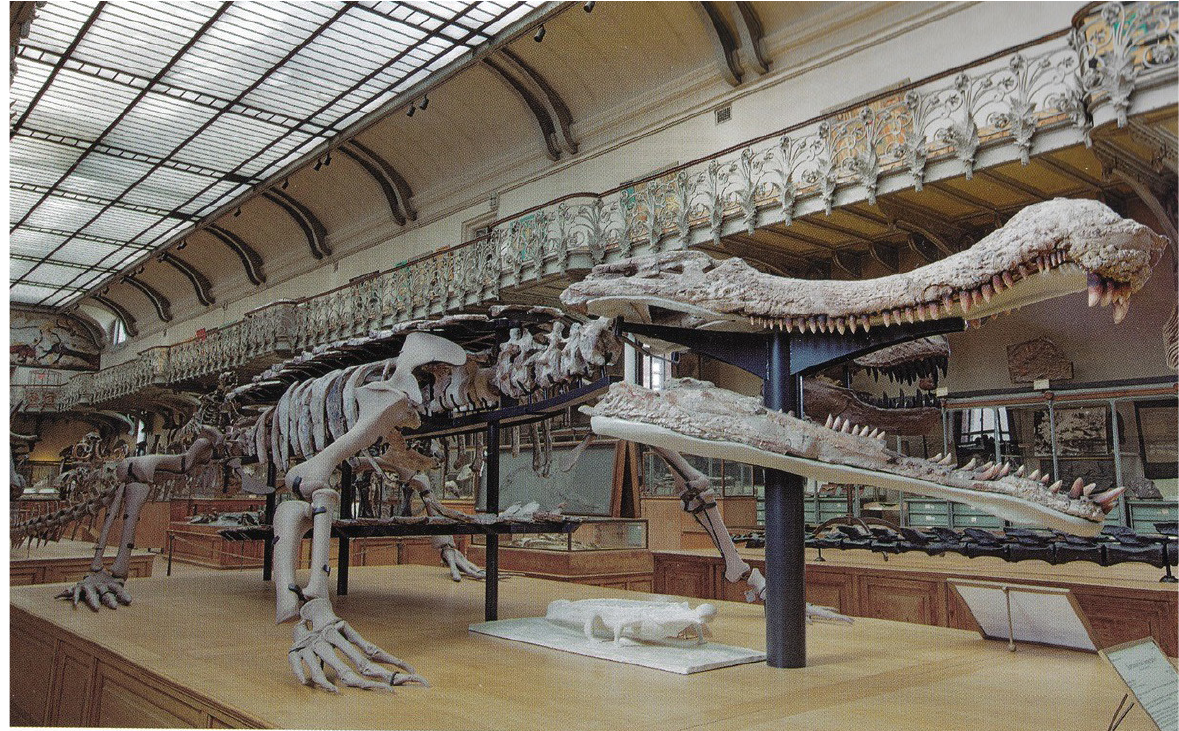
Figure 3. Sarcosuchus imperator , skeleton of 12 meters long, in exhibit in the Gallery of Paleontology, Museum national d’Histoire naturelle. Paris, France (photo